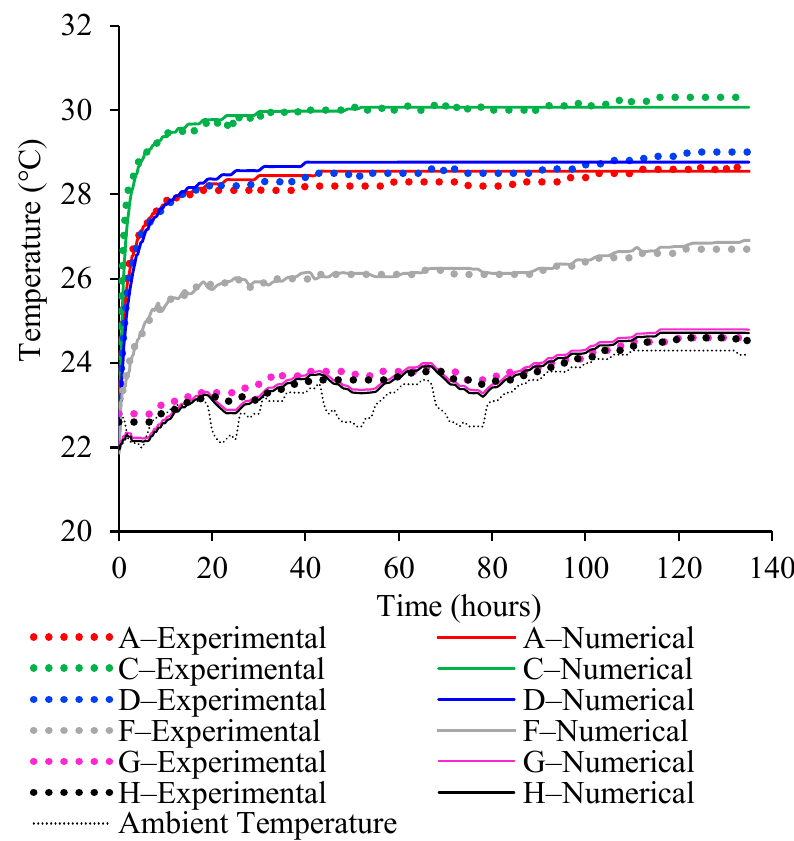
Figure 7. A comparison of the results of the experimental and numerical investigations for the dry